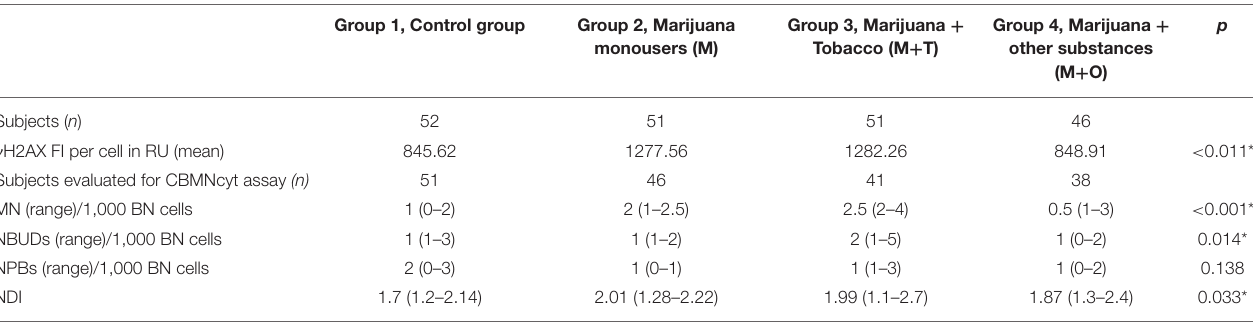
TABLE 2 | DNA damage impact on lymphocytes of marijuana